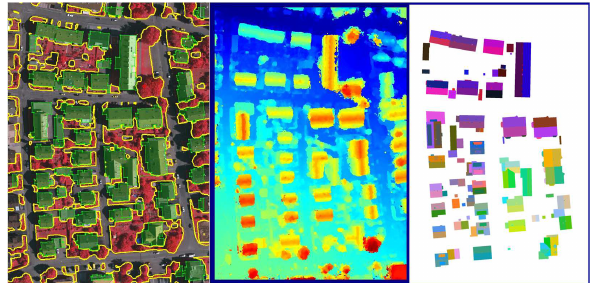
Figure 4: Left: Reference image with building interiors (green) and vegetation areas (yellow) obtained by our method for the data set Vaihingen . The red channel of the 16-bit image on the left cor- responds to the near-infrared channel. Middle: the corresponding elevation map computed from seven images. Right: Ground truth result on roof plane segmentation, see Sec.4.